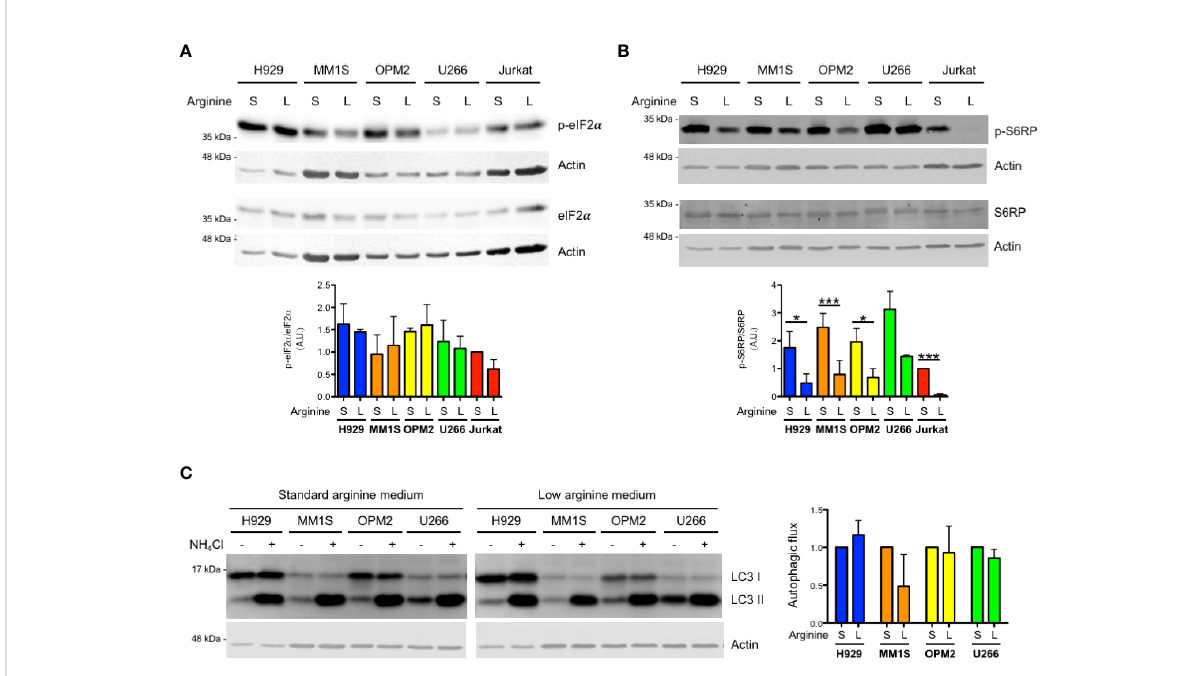
FIGURE 2 Arginine shortage does not activate the integrated stress response but inhibits mTORC1 in myeloma cells. (A, B) Representative immunoblot analyses showing expression of total and phosphorylated eIF2 a (A) or total and phosphorylated S6RP (B) in MM (H929, MM1S, OPM2, U266) and Jurkat cells after 24 h of culture in complete medium containing standard (S) or low (L) arginine concentration as in Figure 1. Actin B serves as loading control. (A, B) Bottom histograms show quanti fi cation of phosphorylated relative to total protein pools (n = 3 independent experiments; A.U., arbitrary unit). Bars indicate average ± s.d. *p<0.05, ***p<0.001, unpaired t -test. (C) Left: representative immunoblot analysis of endogenous unconjugated LC3-I and lipid-conjugated LC3-II in MM lines after 24 h of culture in different arginine concentrations. Cells were treated for 2 h with 50 mM NH 4 Cl or left untreated prior to 1% SDS lysis. Actin B serves as loading control. Right: histogram representing quanti fi cation of autophagic fl ux, estimated as the difference of abundance between LC3II after 2 h NH 4 Cl treatment and LC3II at steady state